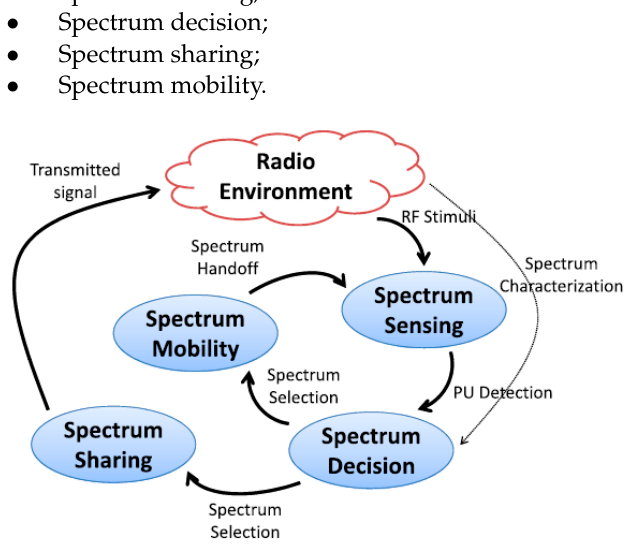
Figure 1. The cognitive cycle implemented by each CR node [15].